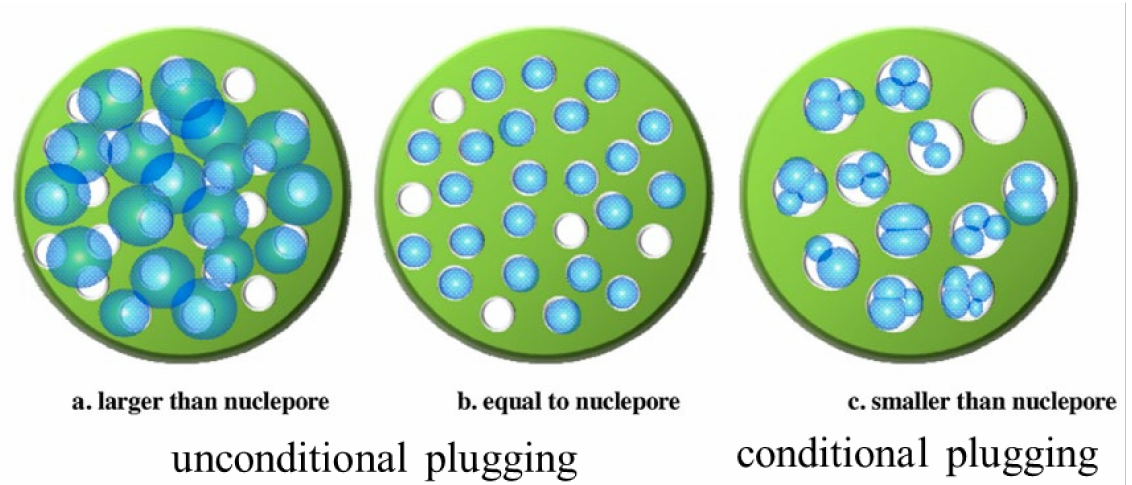
Figure 6. Plugging mechanism of microspheres in nucleopore membranes (revised after [101]).